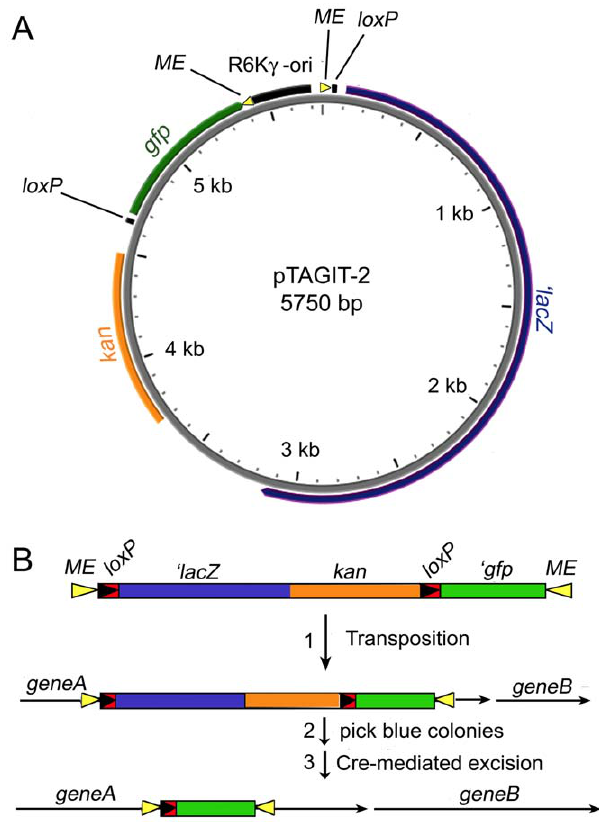
Figure 1. Structure of TAGIT, which randomly inserts gfp into target genes. (A) pTAGIT-2 is an independently replicating plasmid that was constructed by ligating TAGIT-2 to the R6K c origin of replication. (B) ME=mosaic ends recognized by Tn5 transposase (yellow arrowheads), loxP =recognition sequences for Cre recombinase (black arrowheads on red), kan =encodes Kan R in B. subtilis and E. coli (orange). gfp =gene for GFP mutant 2 (green). ’lacZ =gene for b - galactosidase lacking the translational initiation codon (blue). GFP is not fluorescent when exported via the Sec pathway, so the use of b - galactosidase, which is also only active in the cytoplasm, allows the isolation of GFP insertions into the cytoplasmic domain of membrane proteins. A single ORF extends through the leftward ME and loxP site into ’lacZ , so that after transposition, b -galactosidase will be expressed only if TAGIT has inserted in the correct reading frame. Both loxP sites are in the same reading frame, so that after excision of the ’lacZ and kan genes by the Cre recombinase, gfp is in the same reading frame as was lacZ so that translation can continue out of gfp and into the 3 9 end of the target gene. The resulting proteins have GFP inserted into the middle of the target protein.